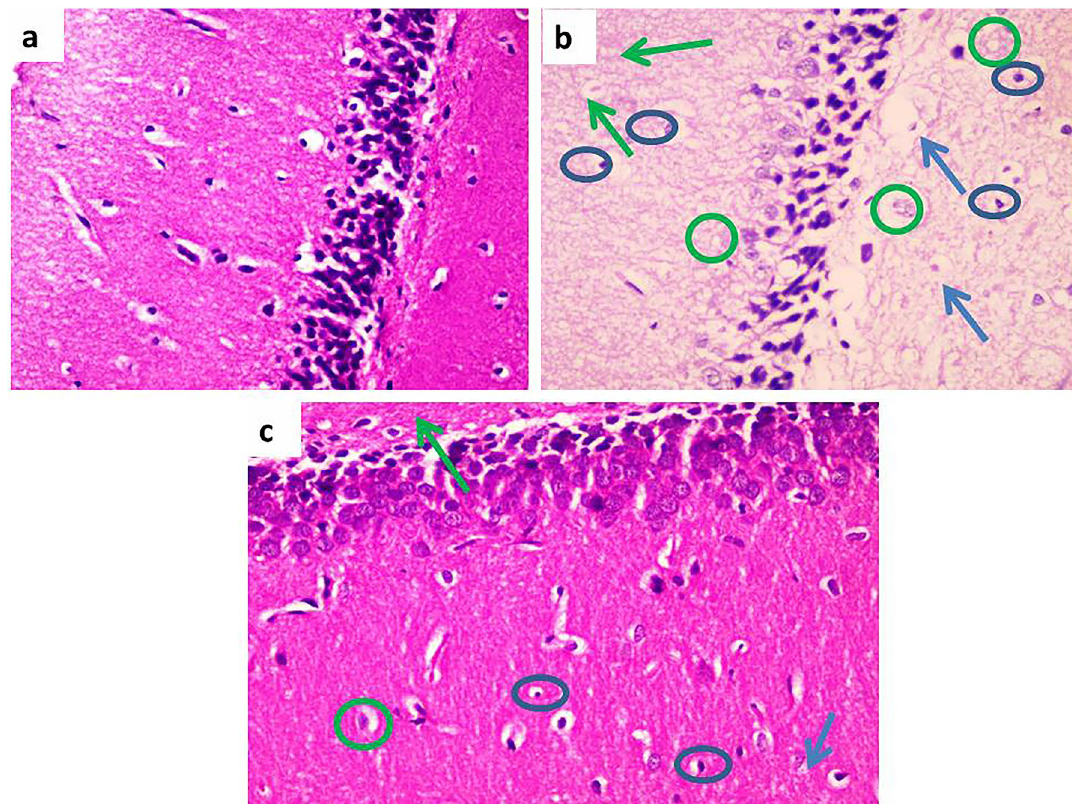
Figure 7. Effect of metformin on hippocampal tissue structure in D-galactose induced-aging rat model. ( a ) Section of the hippocampal tissue in the control group showed unremarkable pathological changes. ( b ) Section of the hippocampal tissue in the D-gal group showed many neuronal degeneration (green circles), and apoptotic bodies (blue circles) with massive oedema (blue arrows) and gliosis (green arrows). ( c ) Section of the hippocampal tissue in the D-gal + Met group showed few neuronal degeneration (green circles) and few apoptotic bodies (blue circles) with mild oedema (blue arrows) and mild focal gliosis (green arrows). (H&E × 200 for A, B and C). (Number of rats =